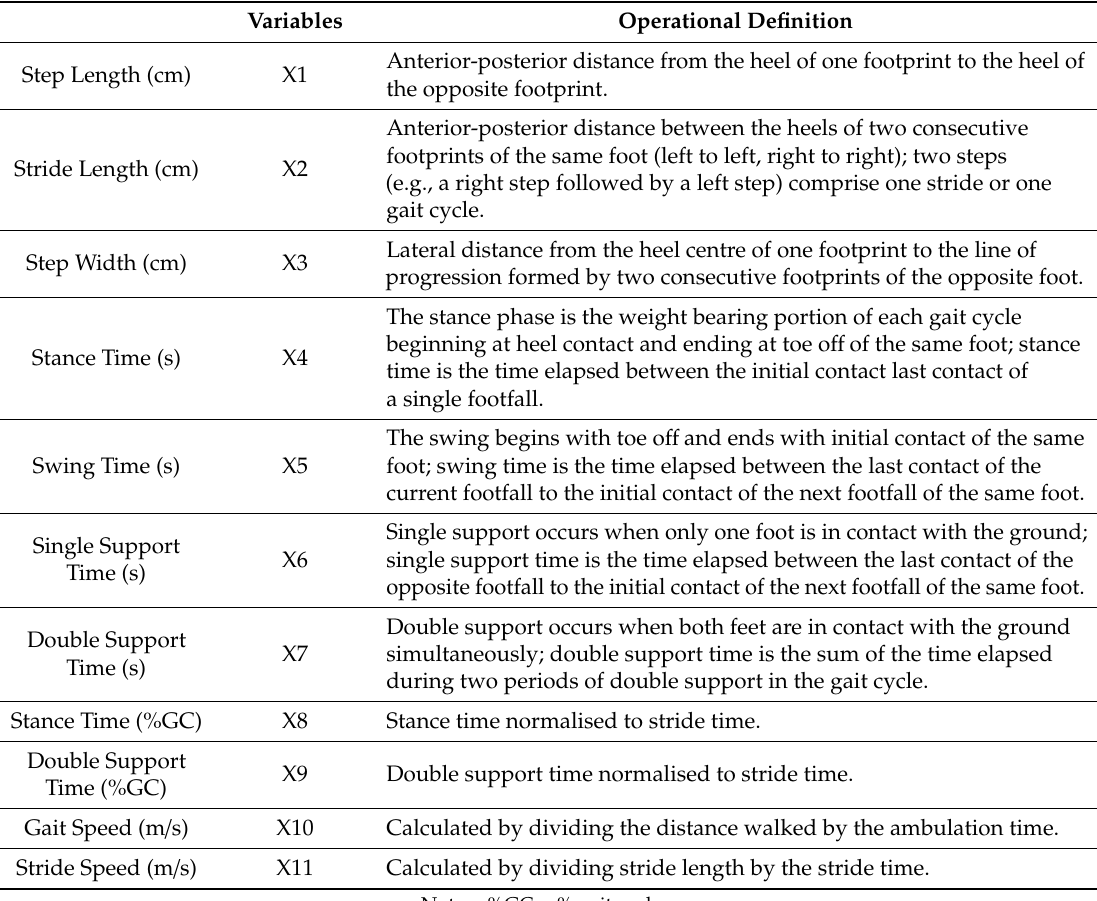
Table 2. Operational definitions of gait parameters and variables.